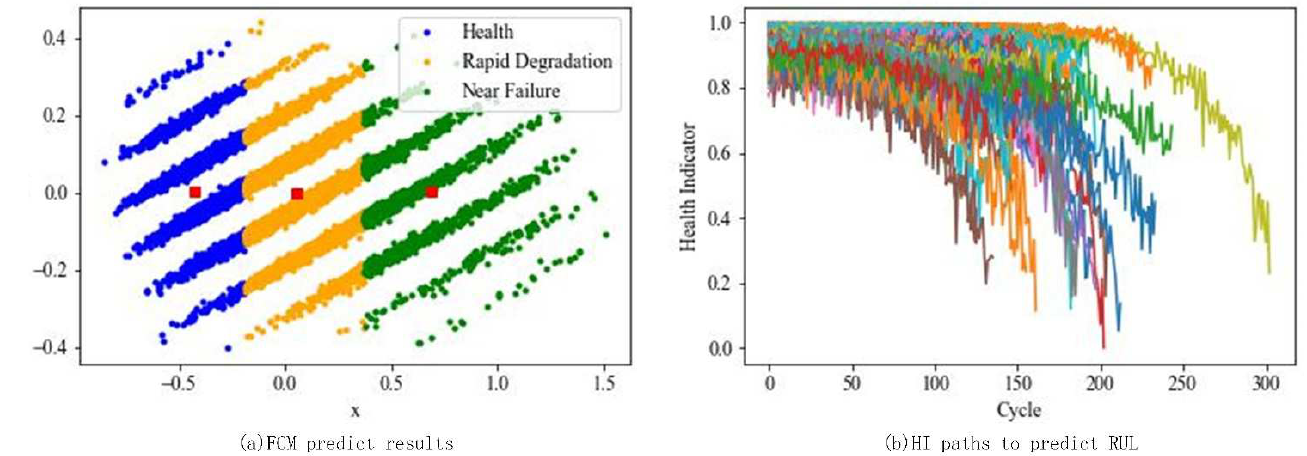
Figure 11. FCM predict results and predicted HI paths.